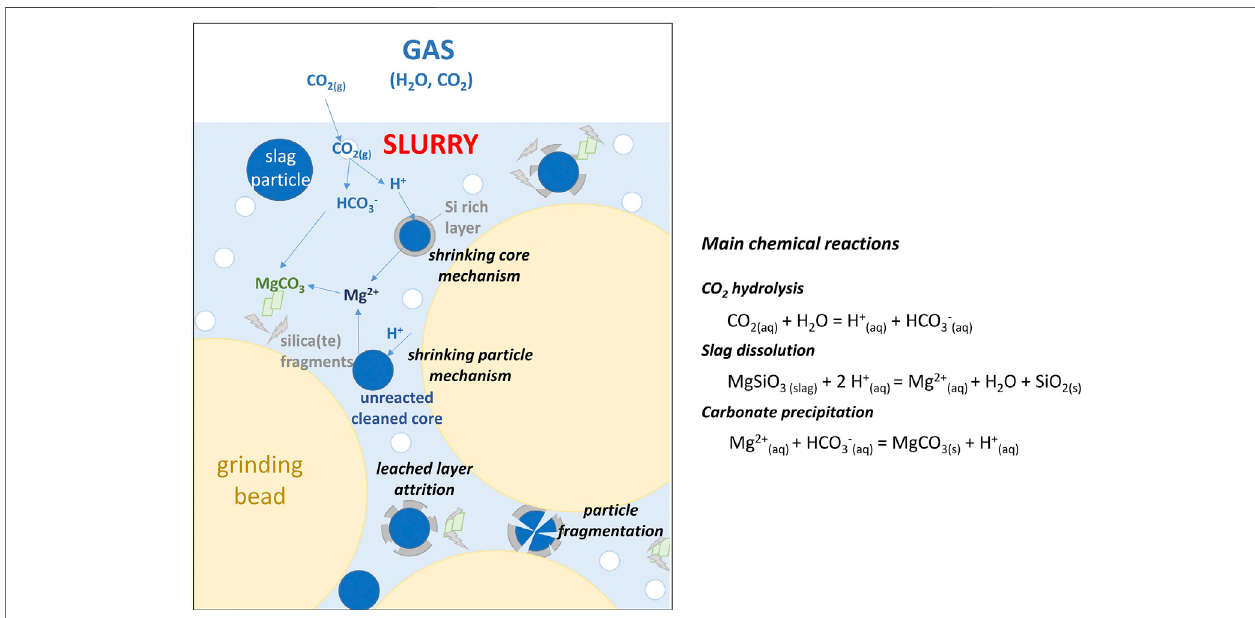
FIGURE 1 | Schematics of concomitant mechanisms during attrition-leaching carbonation in a stirred bead mill.